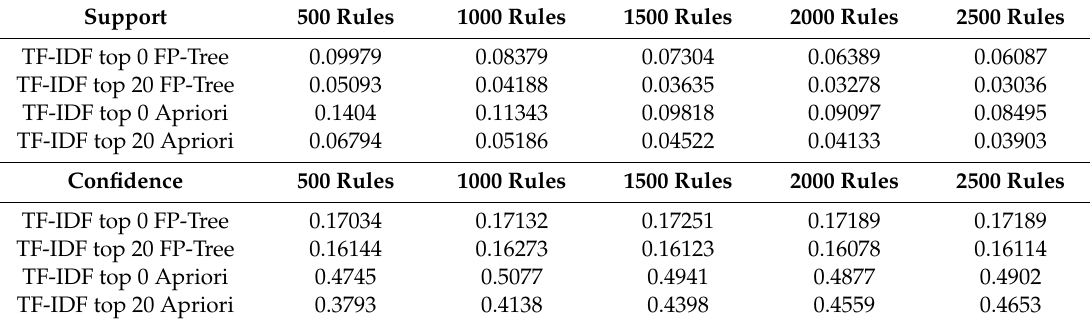
Table 7. Average Support, Confidence Value of Association Algorithms.